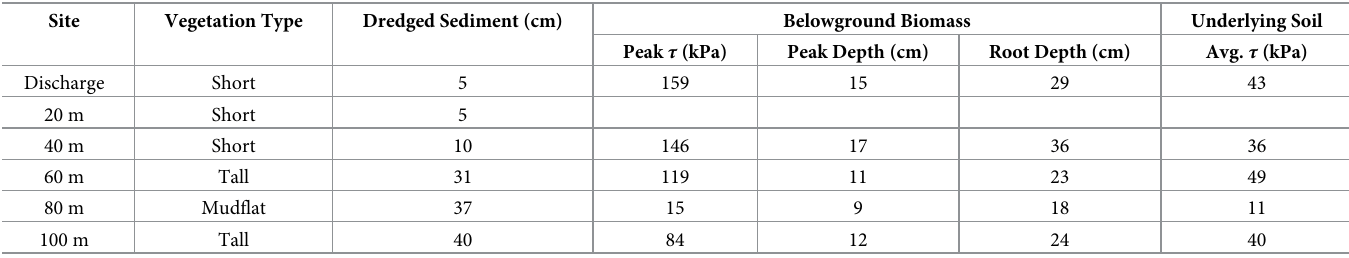
Table 2. Site description and belowground characteristics along Transect B.